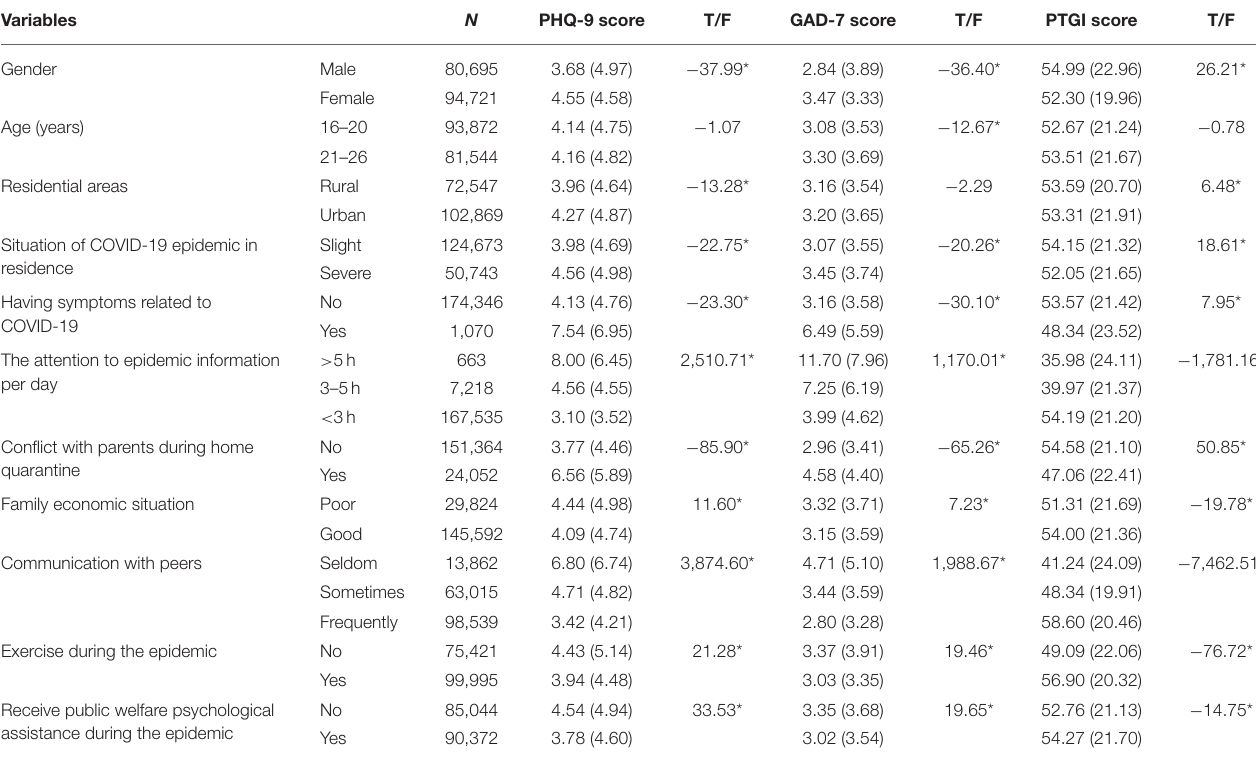
TABLE 2 | Demographic data and the distribution of depressive symptoms, anxiety symptoms, and PTG. Variables